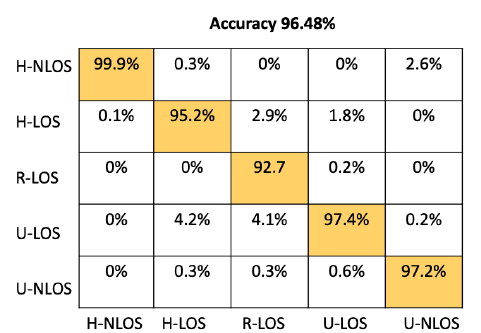
Figure 11. Confusion matrix for the proposed CNN based on CSI approach.